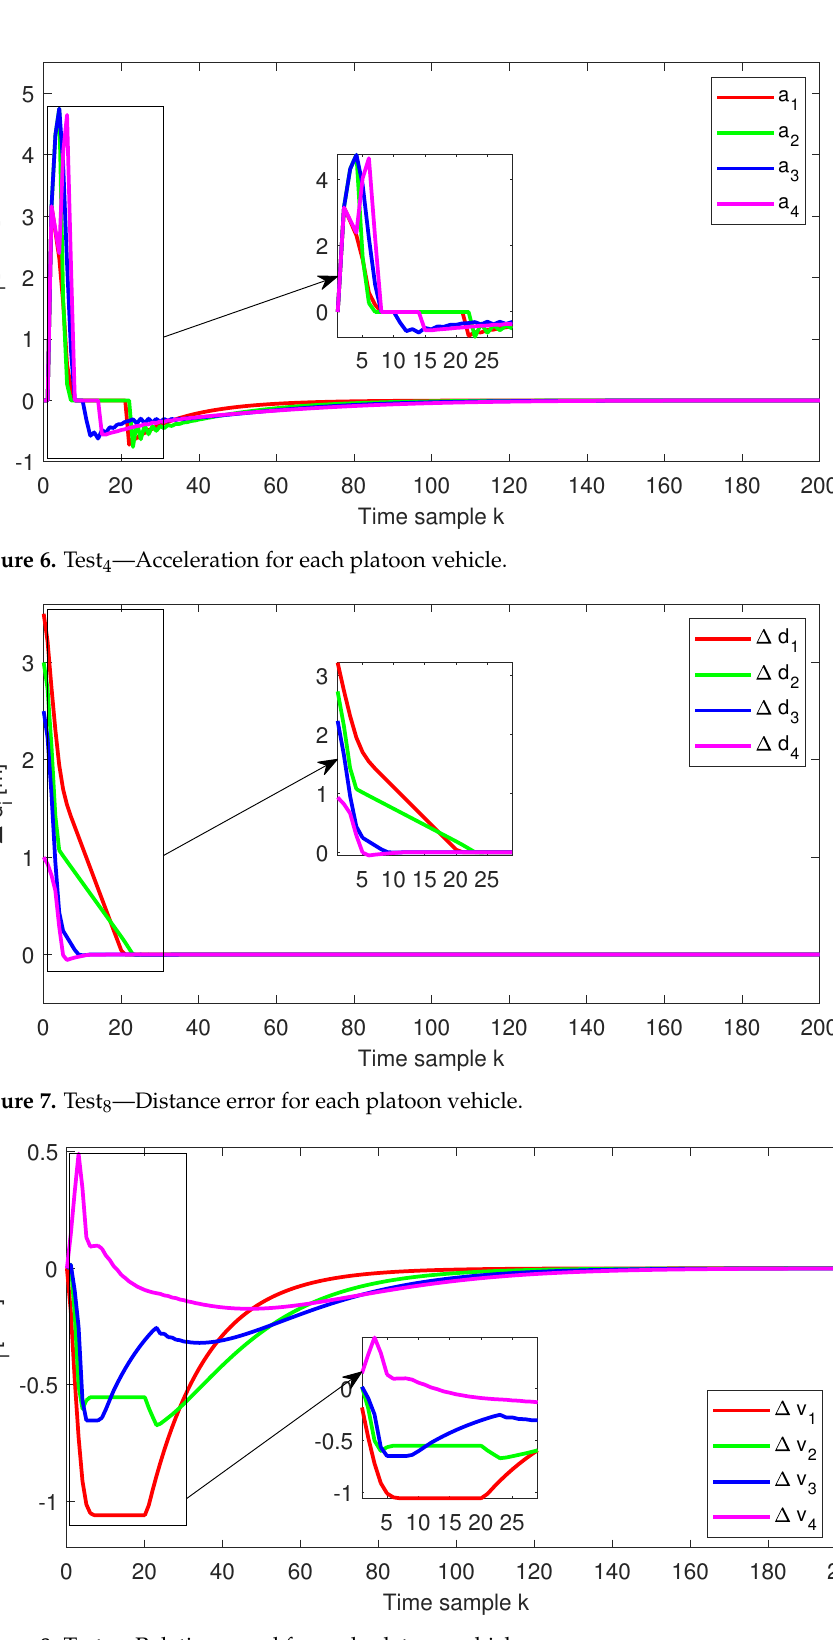
Figure 8. Test 8 —Relative speed for each platoon